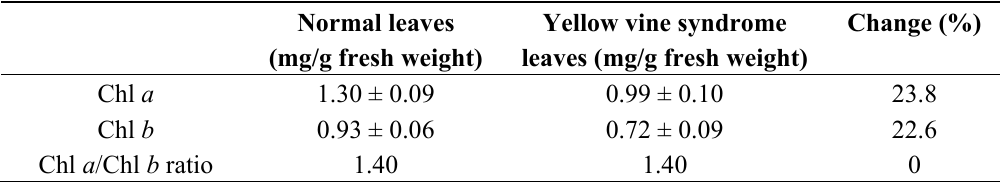
Table 3. Analytical results of Chl a, Chl b, and Chl a/Chl b ratio in yellow vine and normal cranberry